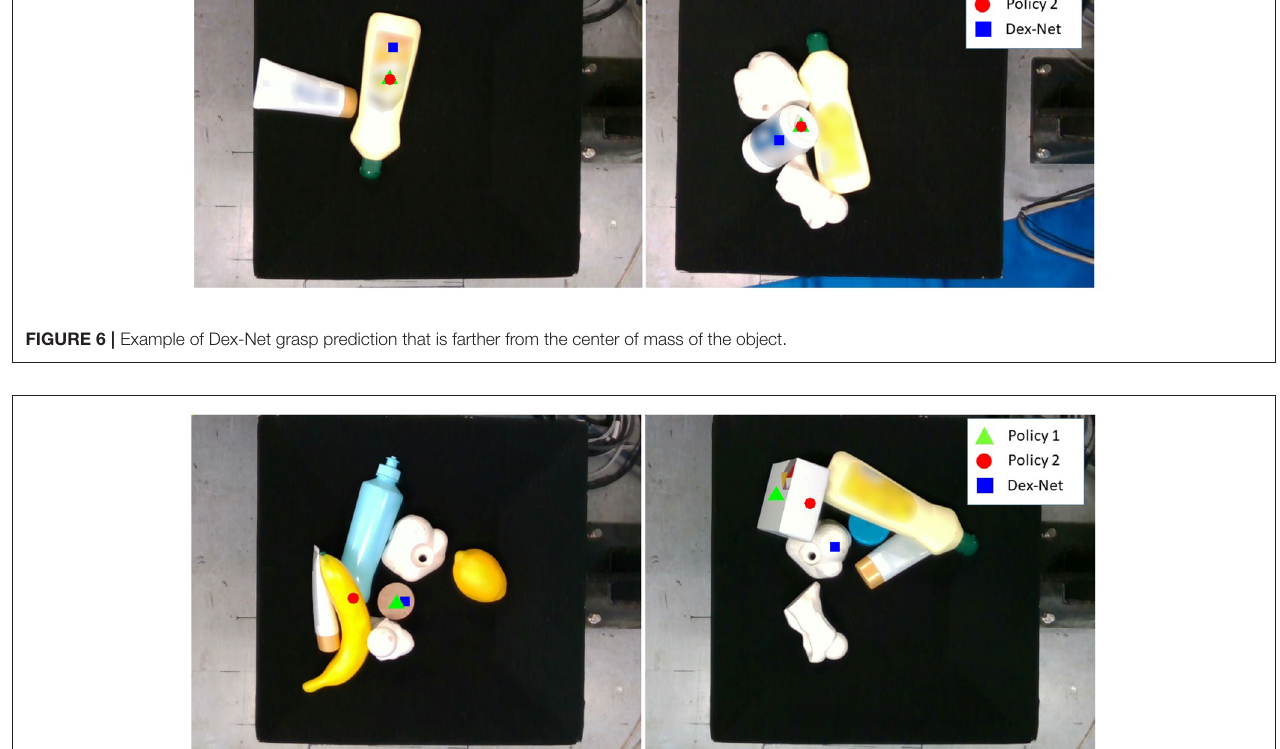
FIGURE 7 | Example of grasps predicted by Dex-Net and Policy 1 that are unreachable or difficult to reach.